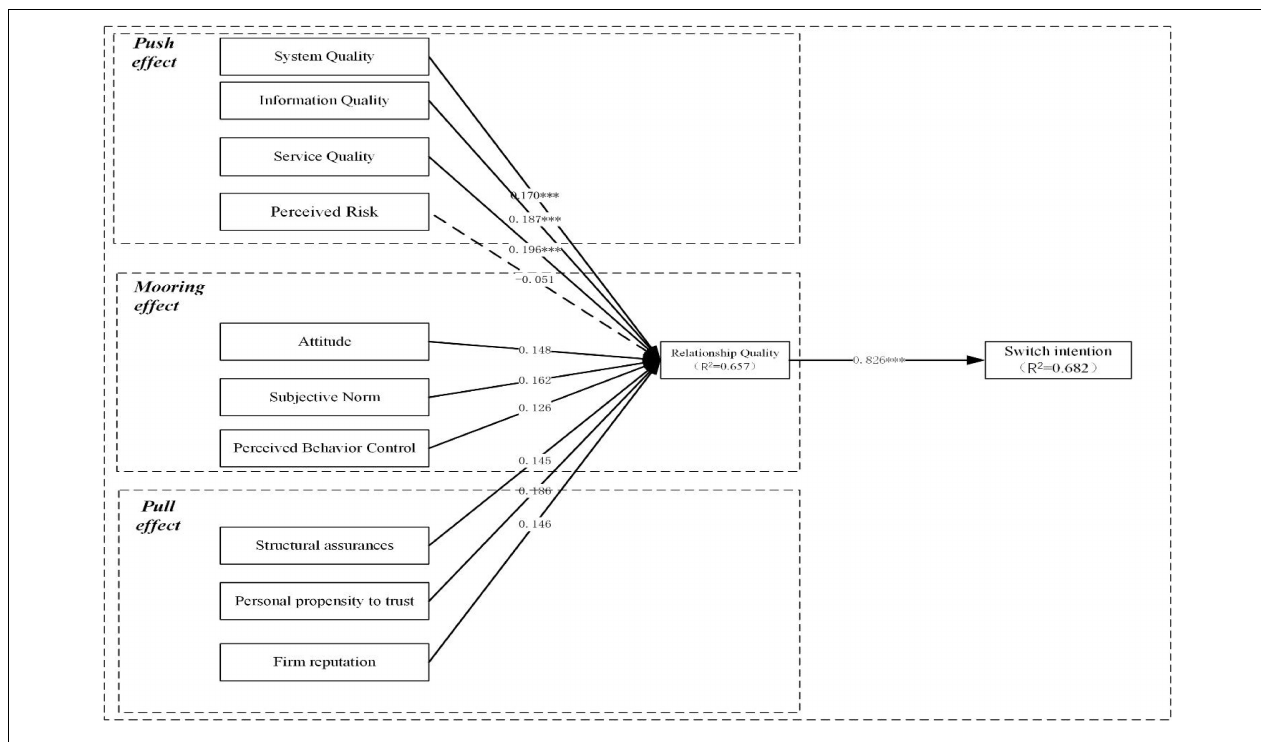
FIGURE 2 | Research model. TABLE 4 | Results of hypotheses